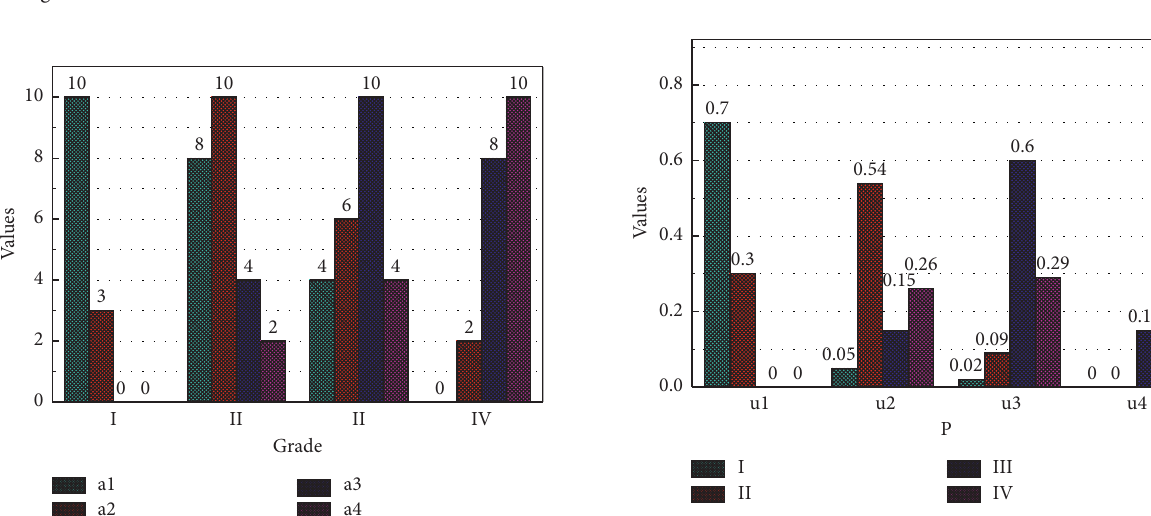
Figure 4: Schematic diagram of the evolution of smart city planning and construction.